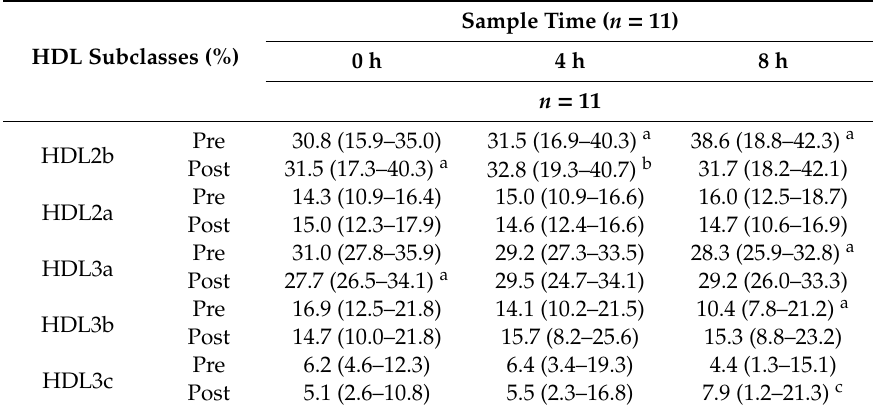
Table 3. E ff ects of MiPo supplementation on high-density lipoproteins (HDL) size distribution, determined by